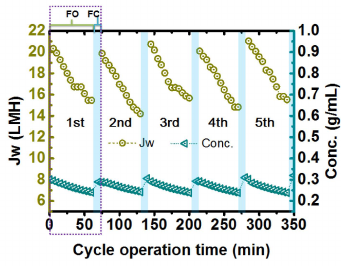
Figure 8. Recovery performance by freezing concentration (FC)